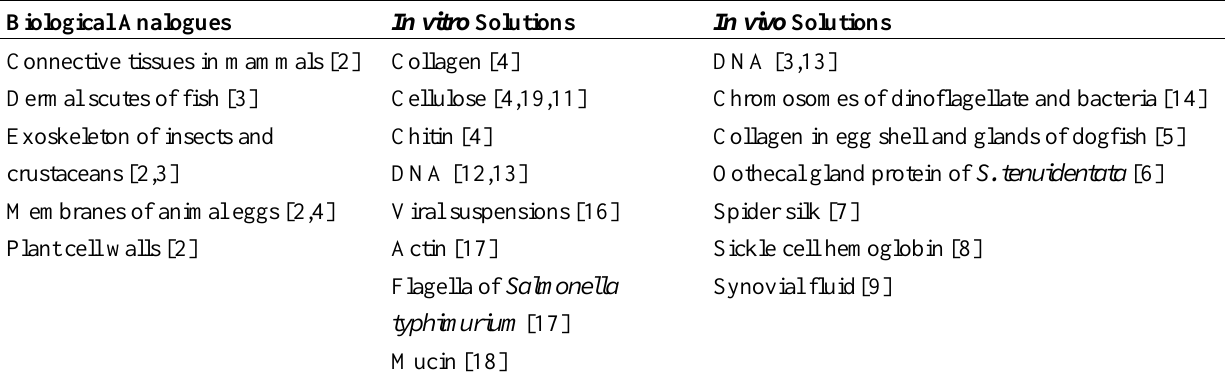
Table 1. Compilation of self-assembling BLCPs and liquid crystalline analogues observed in nature [Adapted from Rey, A.D. Liquid crystal models of biological materials and processes. Soft Matter 2010 , 6 ,